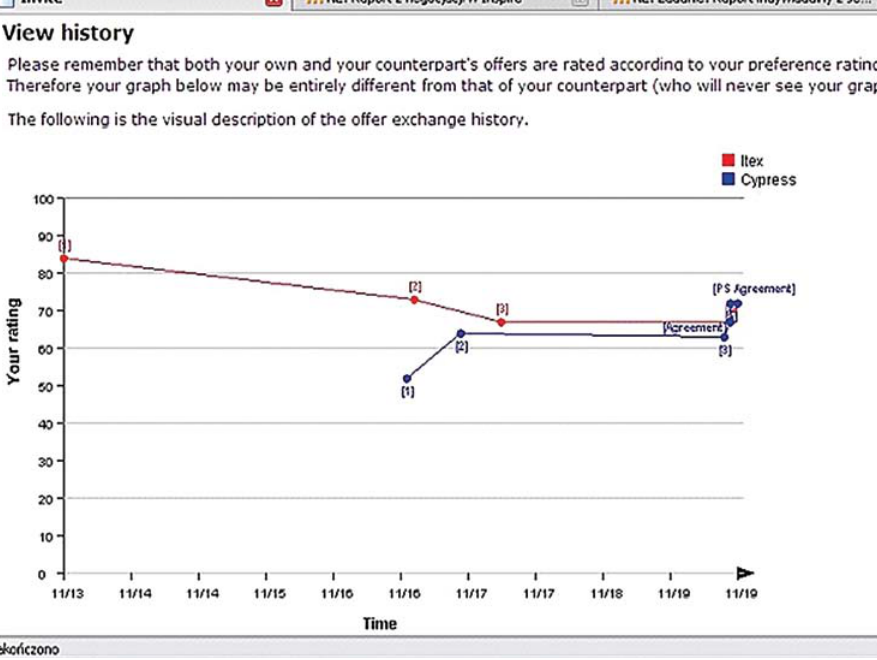
Fig. 8. History graph in eNS